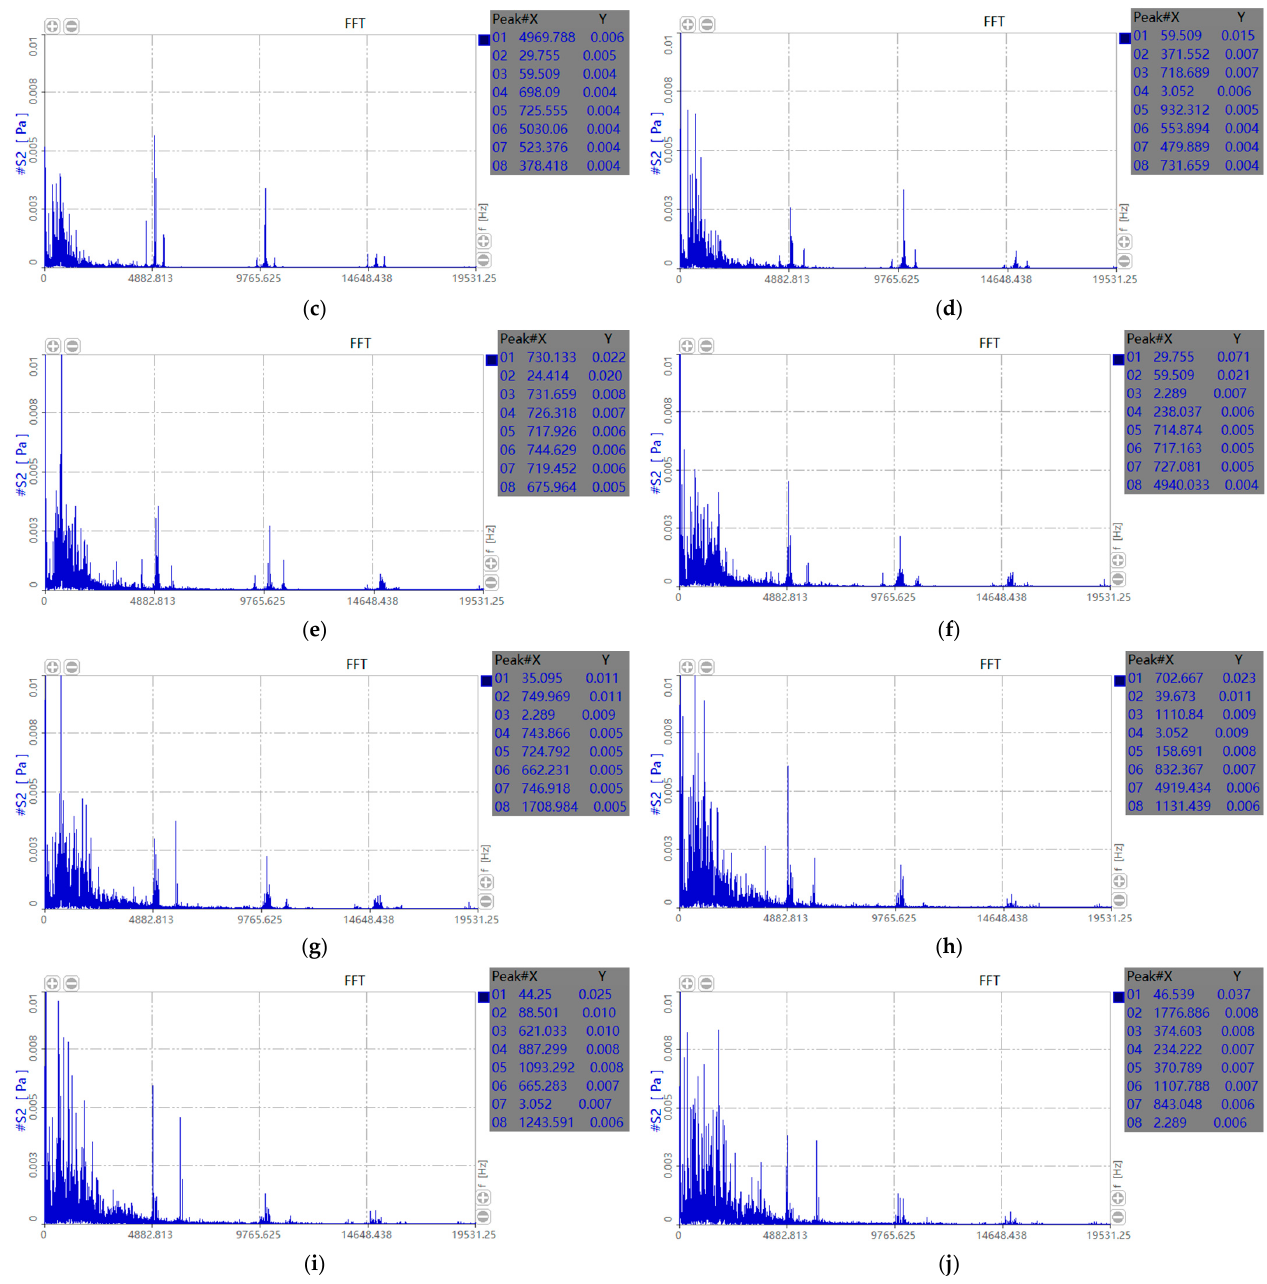
Figure 9. The sound pressure spectrum of the top point #S2 in 10 stages. ( a ) Stage 1, f = 0.1 f 1 ; ( b ) Stage 2, f = 0.2 f 1 ; ( c ) Stage 3, f = 0.3 f 1 ; ( d ) Stage 4, f = 0.4 f 1 ; ( e ) Stage 5, f = 0.5 f 1 ; ( f ) Stage 6, f = 0.6 f 1 ; ( g ) Stage 7, f = 0.7 f 1 ; ( h ) Stage 8, f = 0.8 f 1 ; ( i ) Stage 9, f = 0.9 f 1 ; ( j ) Stage 10, f = f 1 .